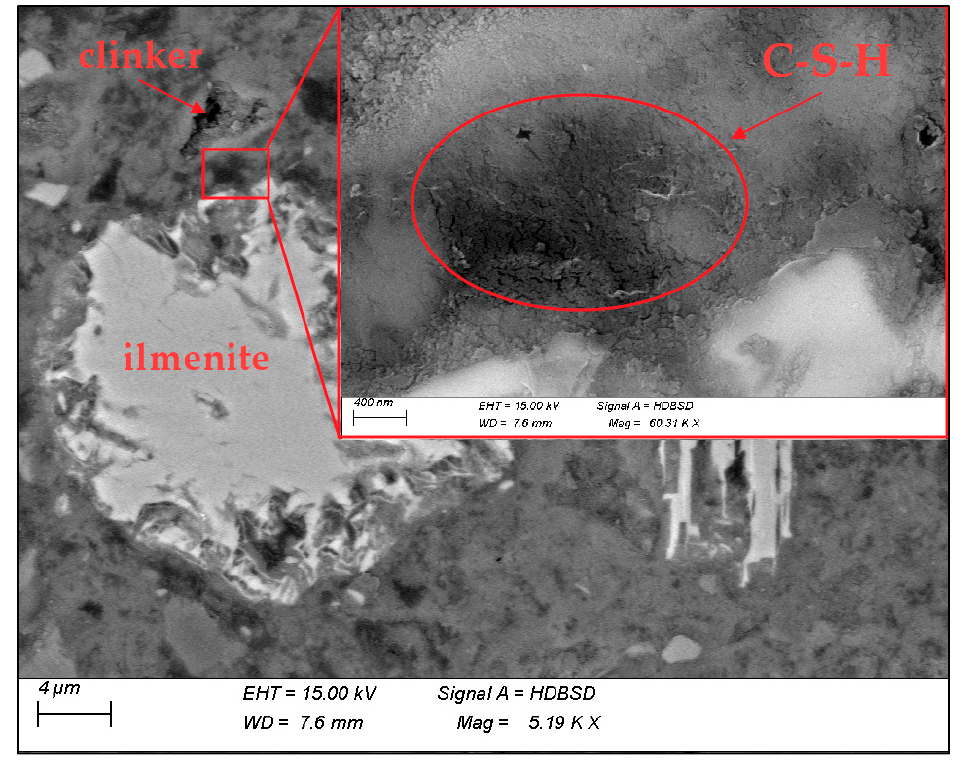
Materials 2020 , 13 , 2904